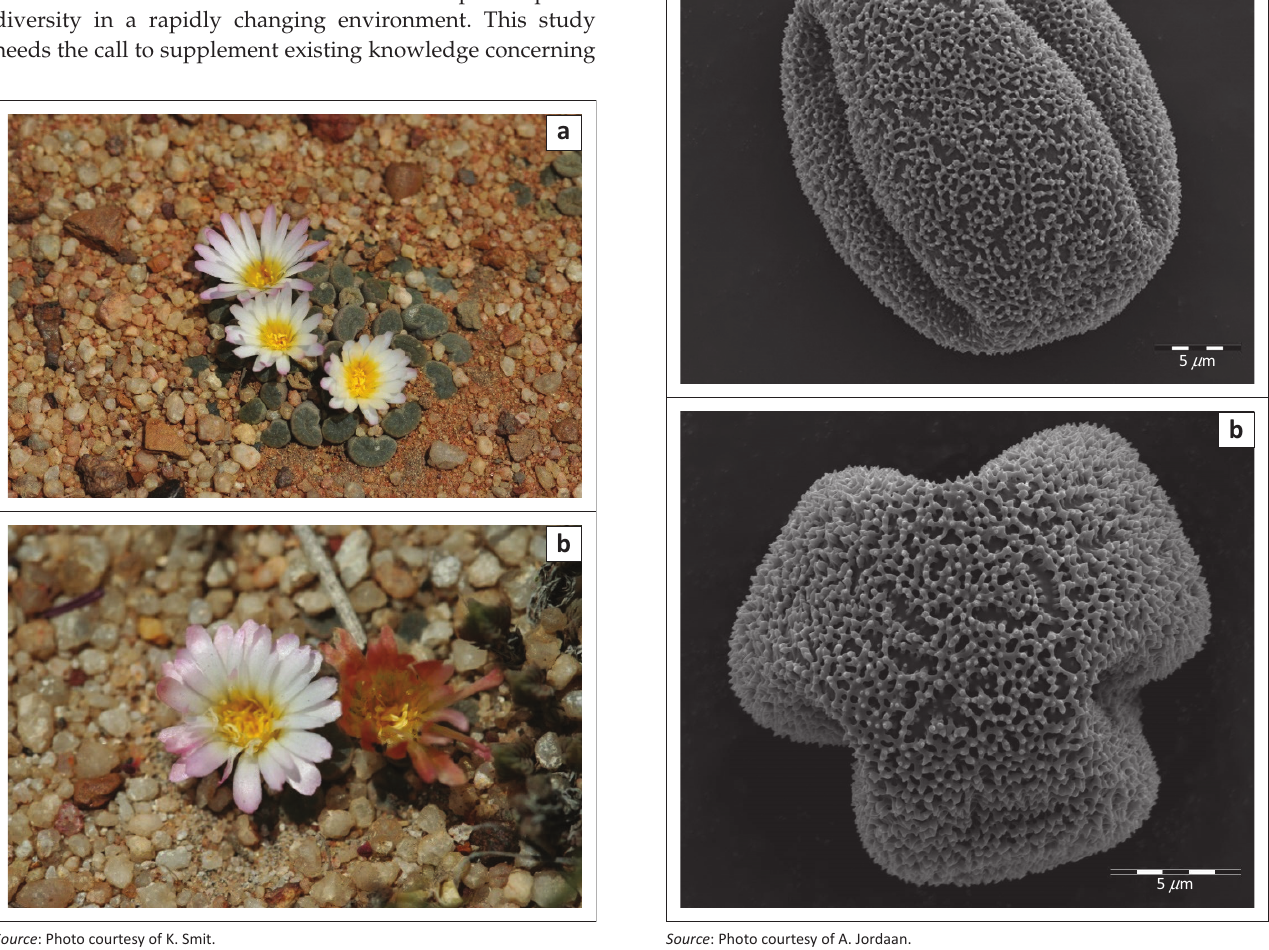
Source : Photo courtesy of A. Jordaan. FIGURE 2: Scanning electron micrographs of Frithia humilis pollen grains in its distal polar-equatorial view (a) and polar view (b).